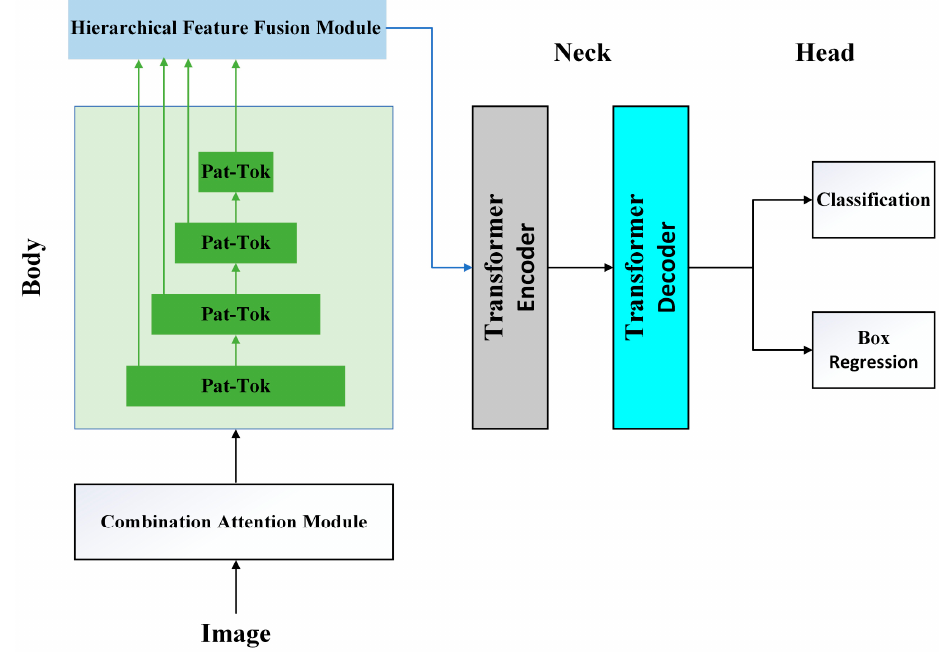
Figure 5. HFD architecture overview. Pat-Tok refers to the embedding of a flattened image patch.